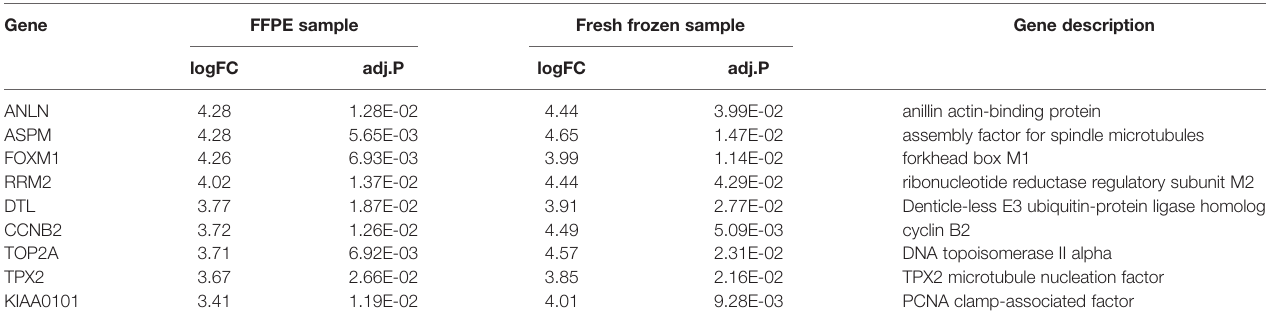
TABLE 1 | DEGs between ACC and